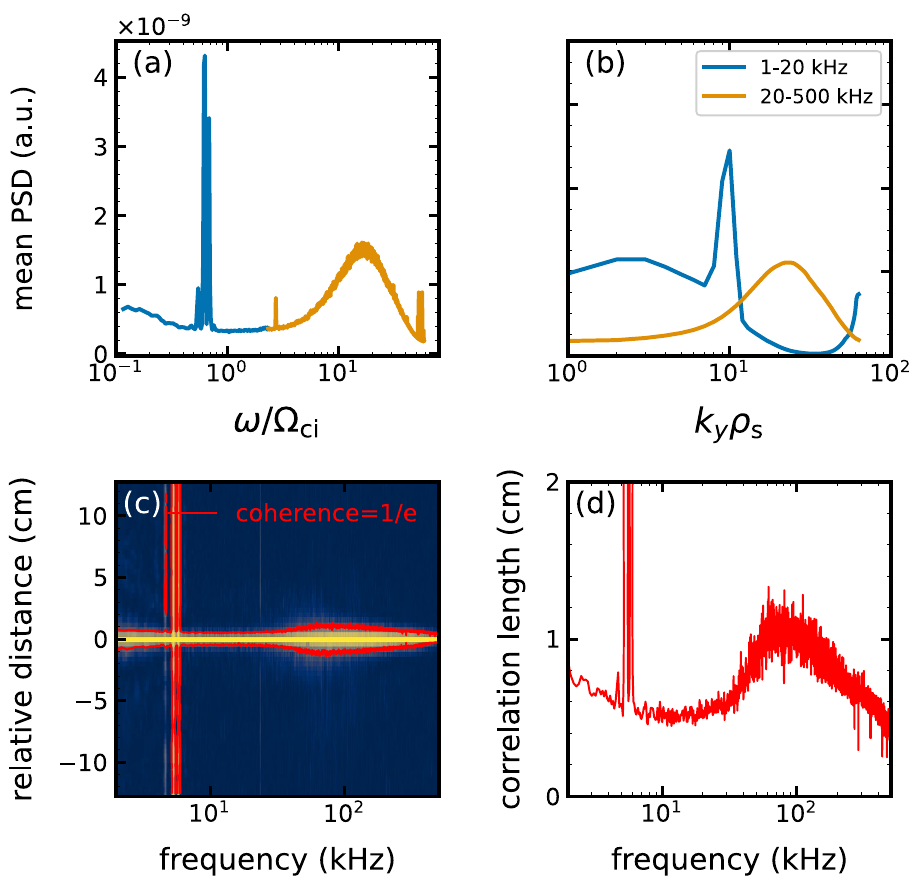
Figure 4. Semi-logarithmic plots of ( a ) normalized frequency ω/� ci spectra and ( b ) normalized wavenumber k θ ρ s spectra of the normalized ion saturation current. Blue and orange lines indicate the low-frequency (1–20 kHz) and high-frequency (20–500 kHz) components, respectively. ( c ) An azimuthal distribution of squared coherence between one of the probes at θ = 0 and the others of 64ch probe array. Red lines in ( c ) and ( d ) shows correlation length